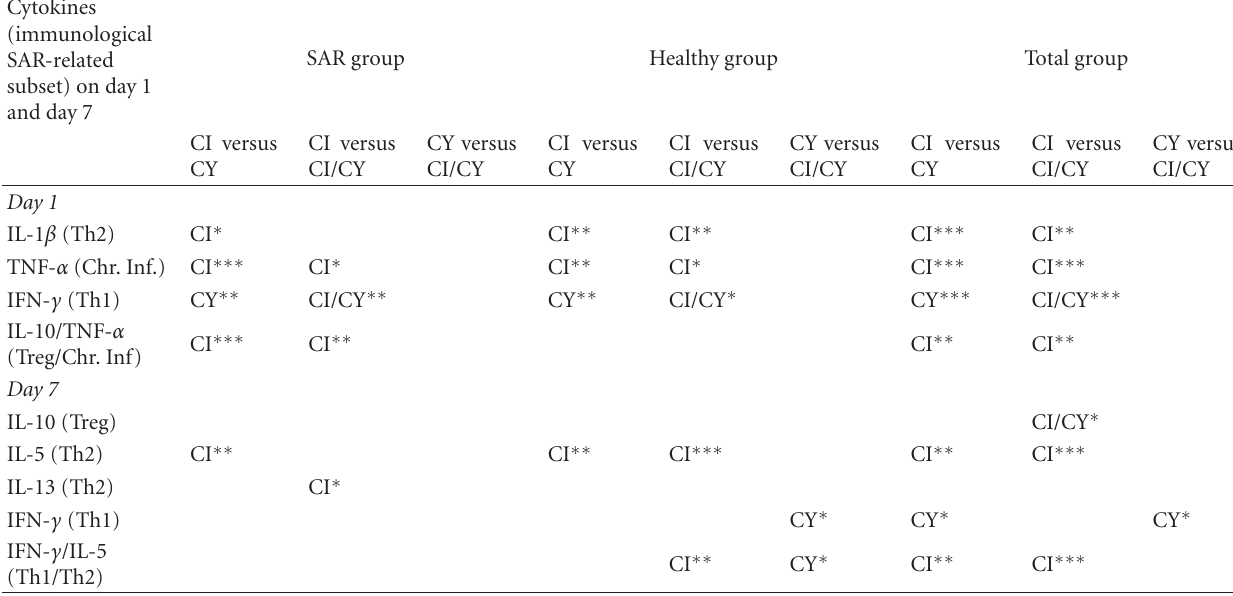
Table 4: Summary of e ff ects on days 1 and 7 in the SAR group, healthy group, and total